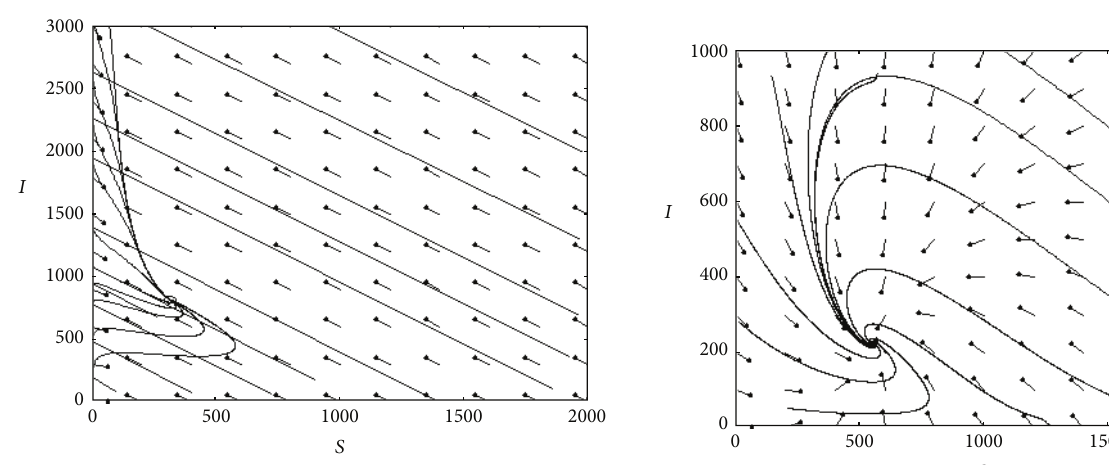
Figure 3: Phase plot of 𝐼 verses 𝑆 showing stability of unique feasible disease free equilibrium point when 𝑅 0 < 𝑅 ∗ 0 < 1 for the parameter values 𝑏 1 = 80 , 𝜆 1 = 0.00001 , 𝛼 = 0.04 , 𝜇 1 = 0.06 , 𝛾 = 0.015 , 𝜆 2 = = 200 , 𝜇 = 0.5 . 0.0002 , 𝑏 2 2